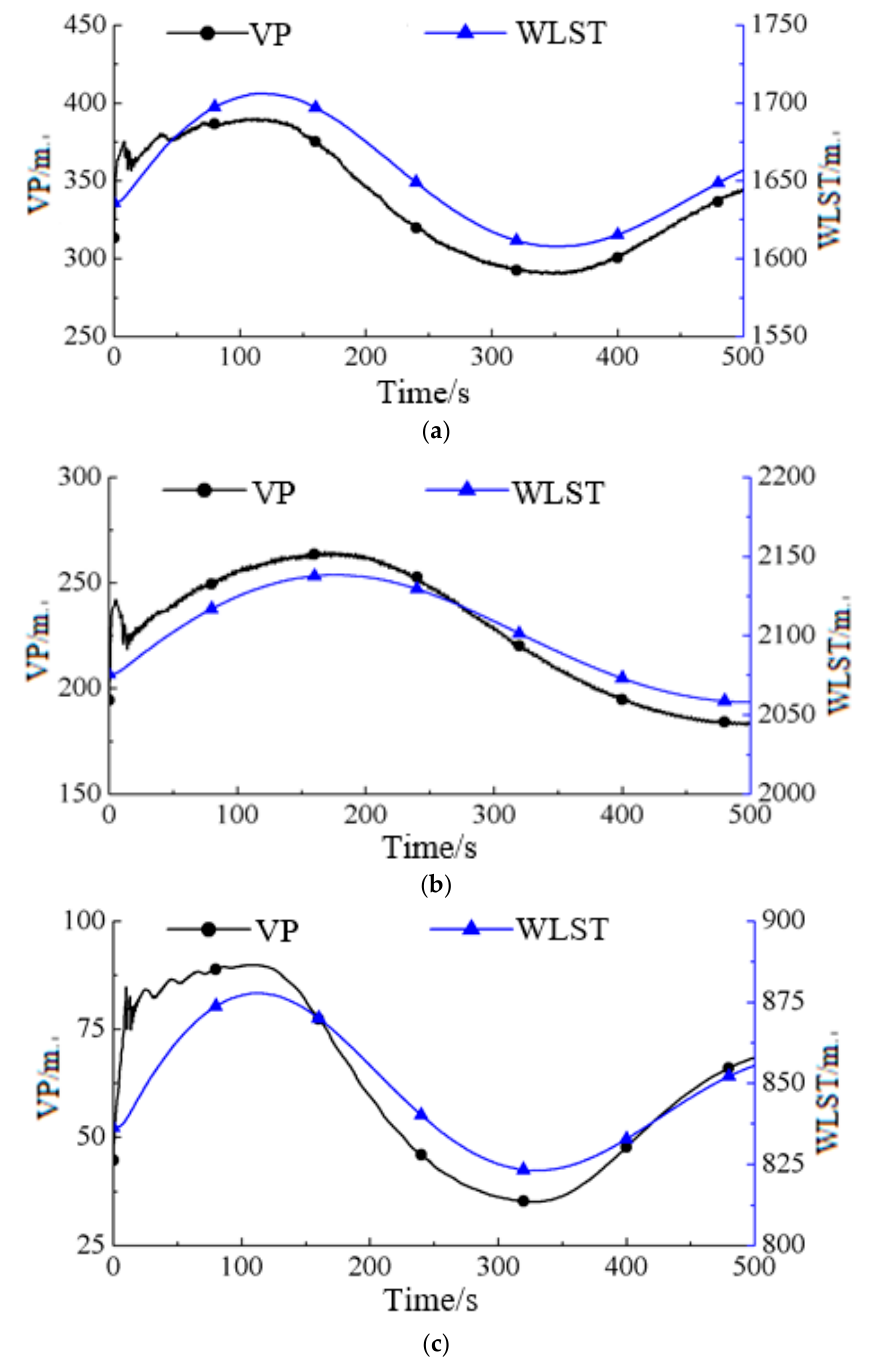
Figure 2. VP and WLST of hydropower stations A, B, and C during load rejection [52]. ( a ) Hydropower station A; ( b ) Hydropower station B; ( c ) Hydropower station C.